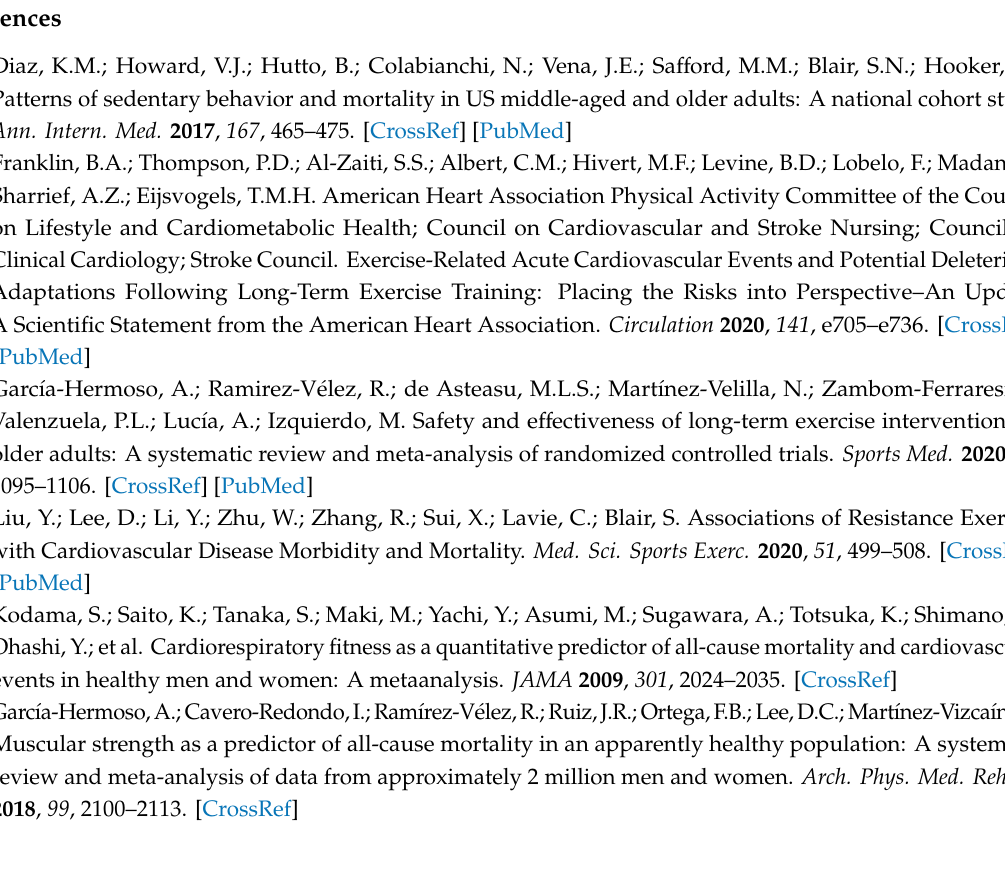
Table S1: Results by age groups and gender in the HGS (kg) in di ff erent